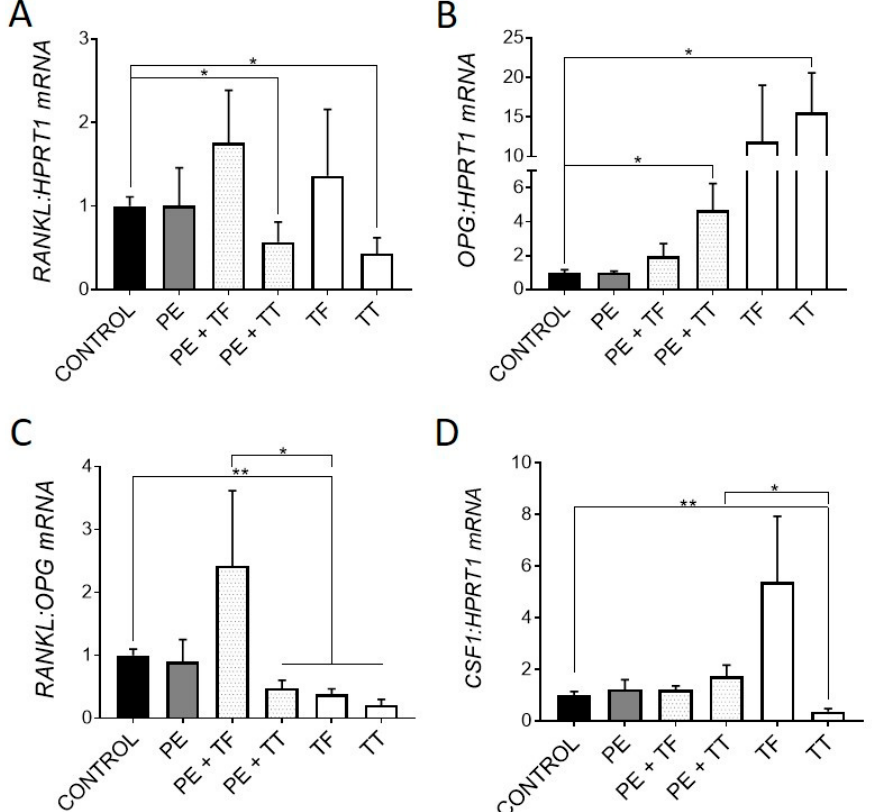
Figure 2. Effect of vitamin E and UHMWPE particles on osteoclastogenic gene expression. Relative gene expression was measured for genes associated with osteoclastogenesis: RANKL , OPG , the pro-osteoclastogenic RANKL : OPG mRNA ratio and CSF1 mRNA expression ( A – D ). Data shown are means ± standard error of the mean (SEM) of quadruplicate experiments analysed in duplicate. Significant differences are denoted by * p < 0.05, ** p < 0.01.